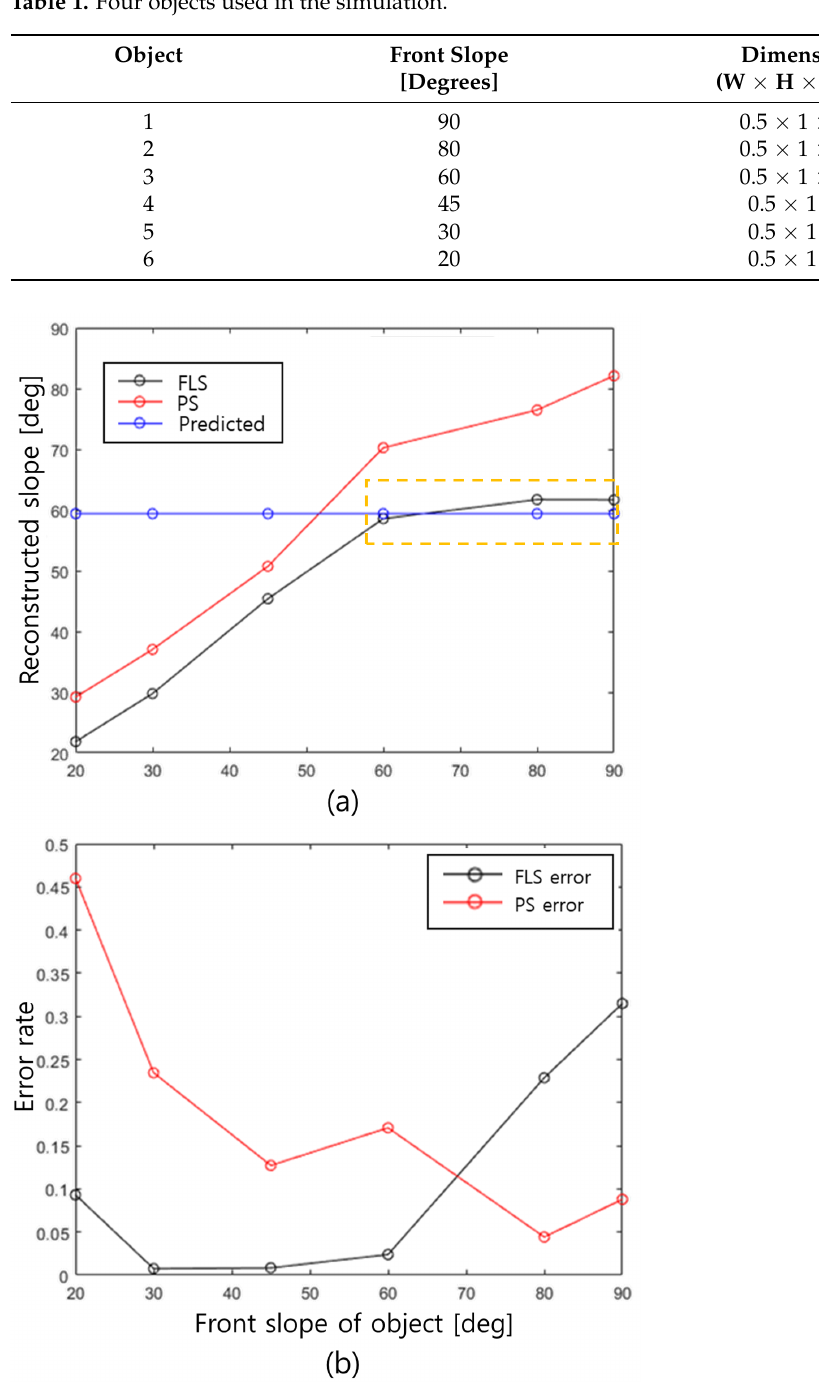
Figure 3. Estimated ( a ) slope and ( b ) error rate with different front slopes of objects; black and red circles denote FLS and PS results, respectively. The blue circles in ( a ) represent the predicted values from Equation